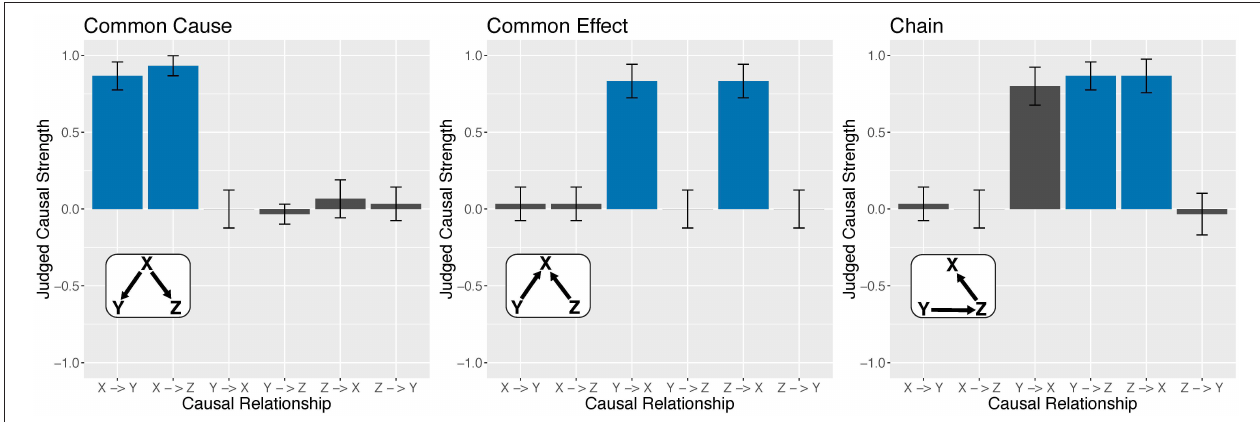
FIGURE 7 | Participant judgments of causal relationships for three tested networks. Bar colors correspond to the true causal structure, namely, blue for regular connections and gray for no connection. Bar heights represent mean θ reported by participants (regular = 1 and none = 0). Because these networks included only regular causal relationships, no instances of inverse relationships are shown. Error bars Denote 95% confidence